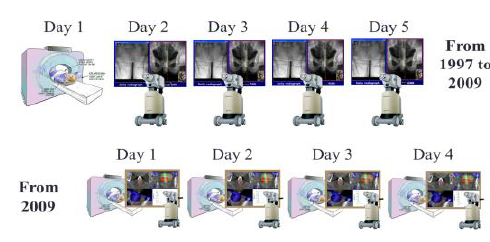
Figure 4. Intracavitary mould